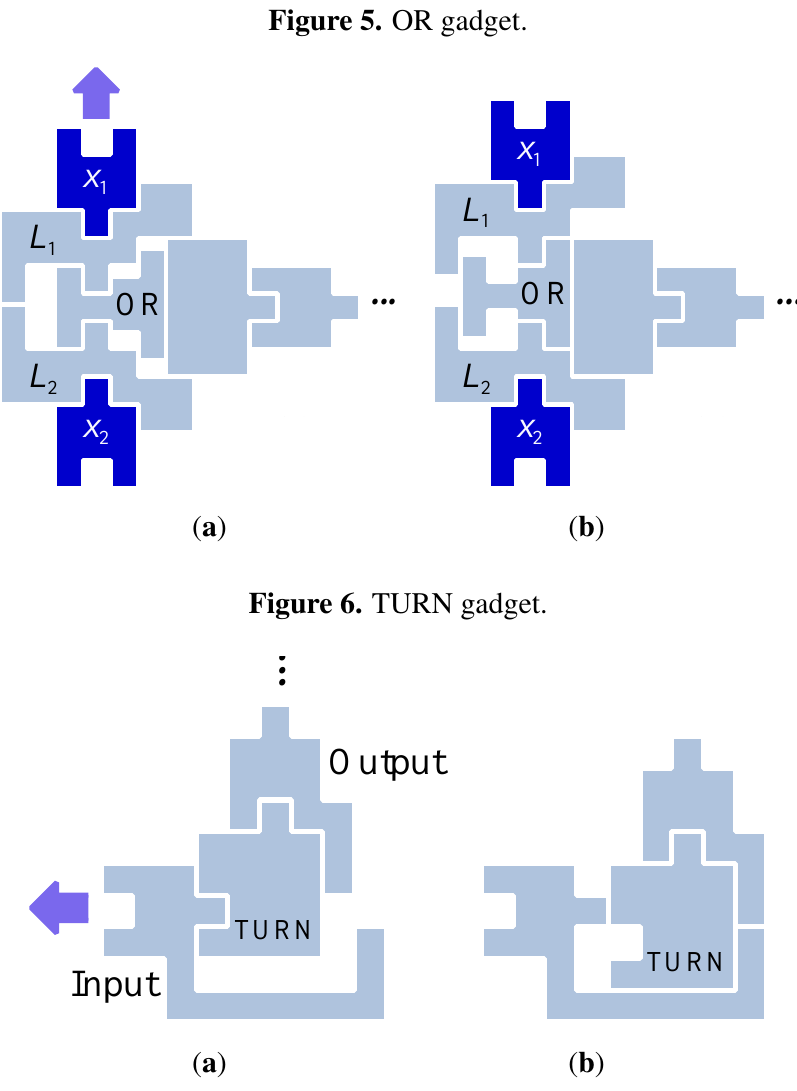
Figure 5. OR gadget.